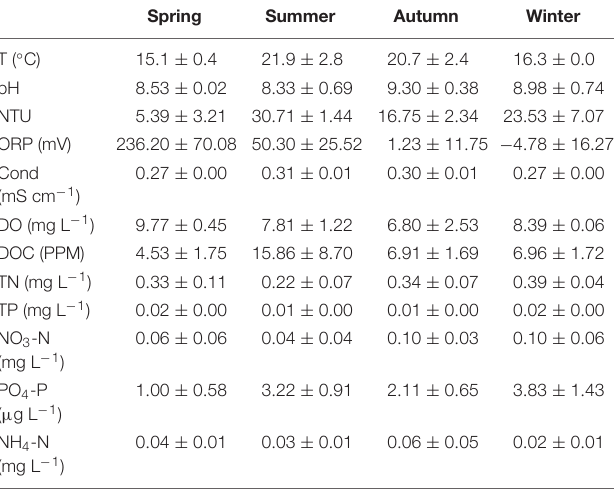
TABLE 1 | The key environmental factors among different seasons of Lake Fuxian in 2015. Spring Summer